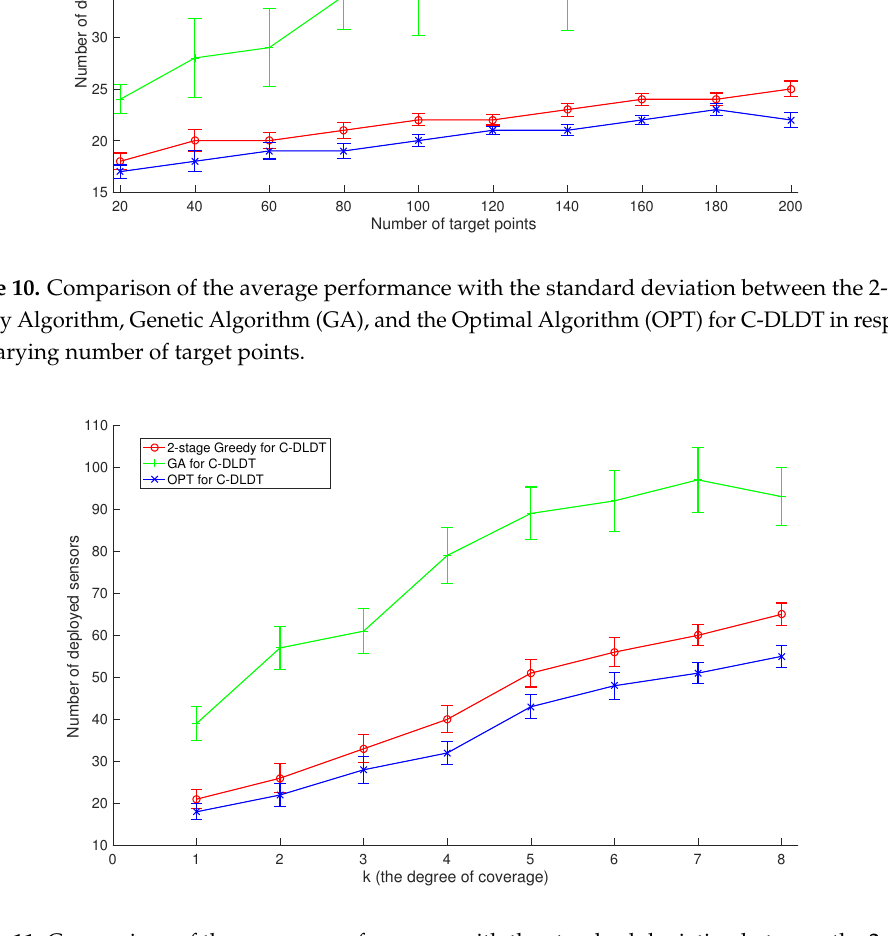
Figure 11. Comparison of the average performance with the standard deviation between the 2-stage Greedy Algorithm, Genetic Algorithm (GA), and the Optimal Algorithm (OPT) for C-DLDT in response to varying k